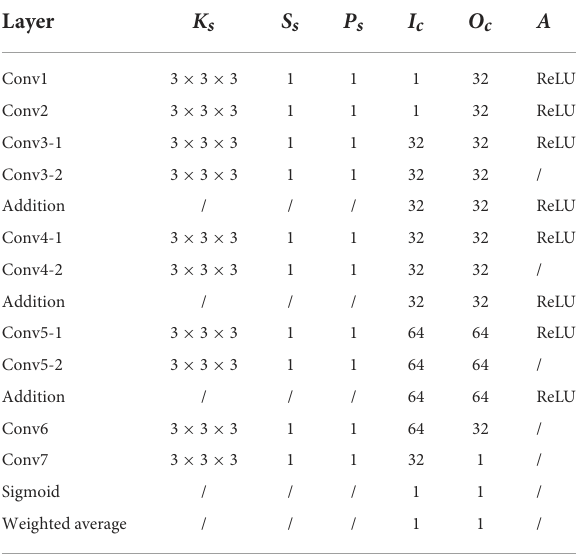
TABLE 1 Detailed parameter configuration of the